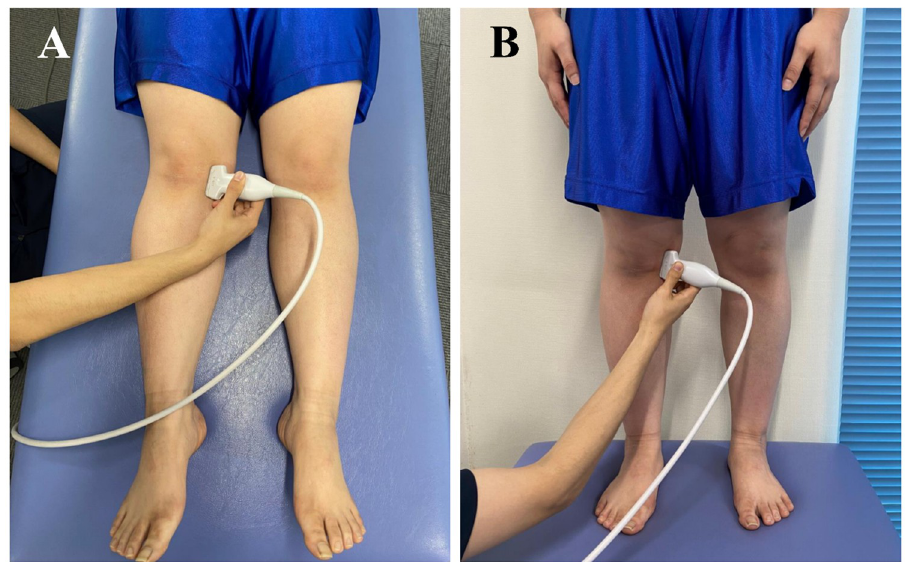
Fig 1. Measurement of the medial knee joint using ultrasound. Ultrasound assessed the medial meniscus when the patient was in the supine ( A ) and standing ( B ) positions. Both measurements were performed at maximum knee joint extension in each patient. The transducer was placed longitudinally at the level of the medial collateral ligament at the medial aspect of the knee joint.